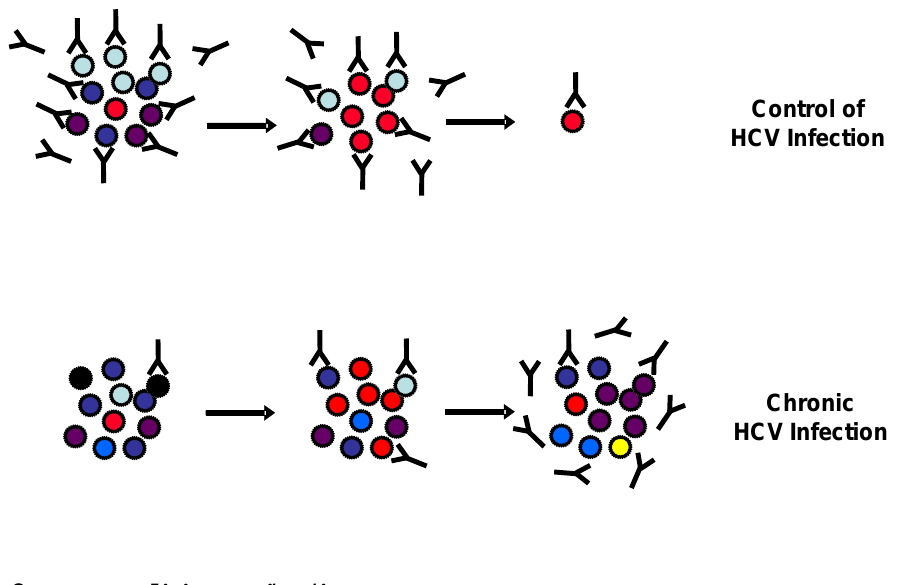
Figure 1. Viral escape from neutralizing antibody responses. In infected individuals, HCV exists as a quasispecies, i.e. , a pool of constantly changing, distinct but related genomic variants. Resolving HCV infection is associated with a relatively stable pool of viral variants and the early induction of high-titer cross-neutralizing antibodies. Chronic HCV infection is correlated with diversification of the quasispecies population associated with a delayed induction of cross-neutralizing antibodies allowing viral escape from the host humoral